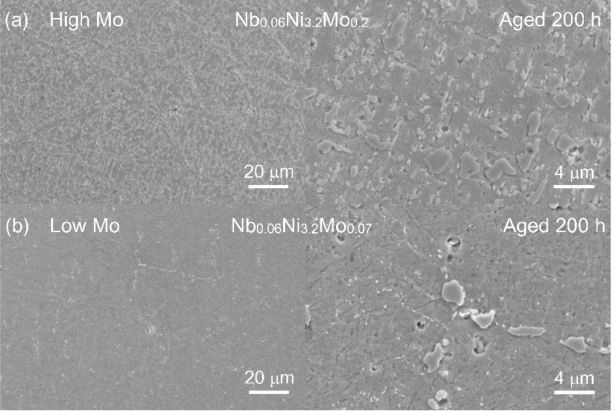
Figure 5. The secondary electron images in different magnification of ( a ) 2-4 Nb 0.06 Ni 3.2 Mo 0.2 (higher Mo content) and ( b ) 2-6 Nb 0.06 Ni 3.2 Mo 0.07 (lower Mo content) after being aged at 800 ◦ C for 200